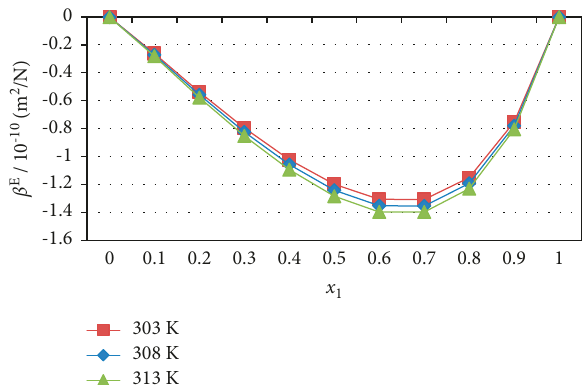
Figure 3: Variation in excess adiabatic compressibility with mole fraction of chlorpheniramine and 1-propanol at 303K, 308K, and 313K in the atmospheric pressure.